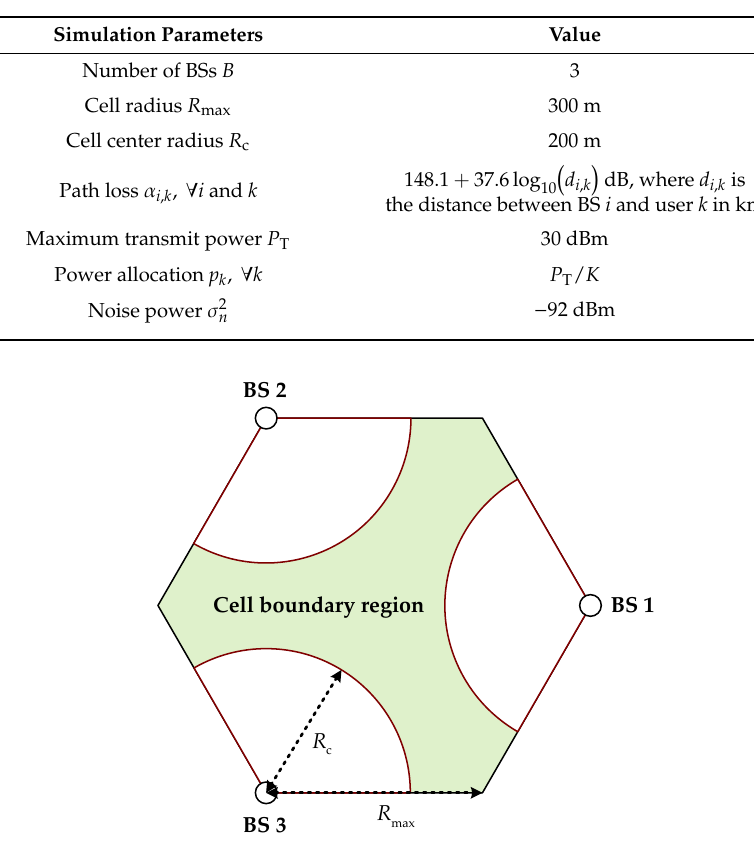
Figure 2. A three-cell cellular